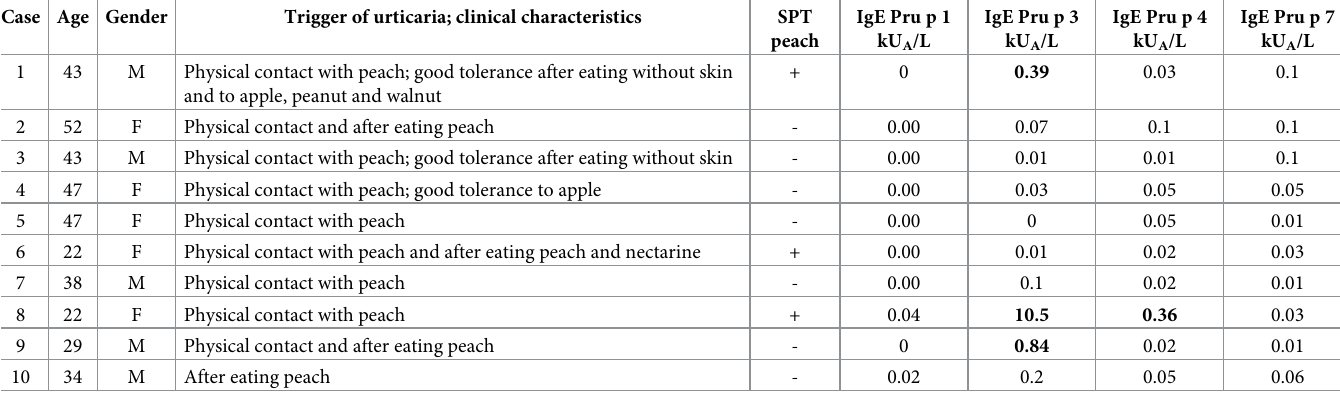
Table 2. Clinical characteristics of participants with urticaria due to peach. Case Age